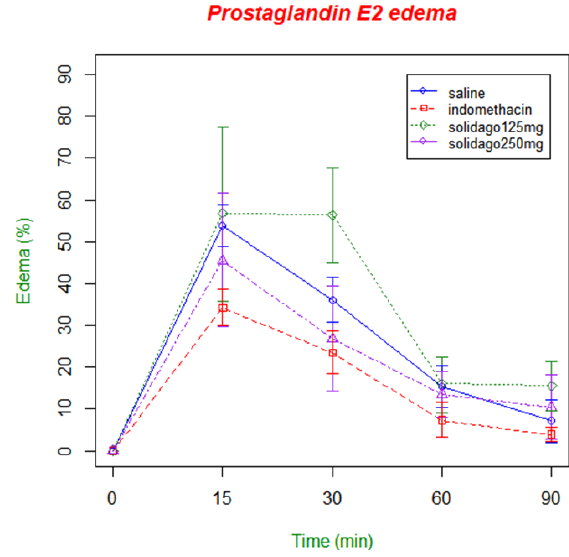
Figure 7 . Variation in paw thickness percent 15 to 90 min after PGE2 administration. Animals were pretreated with vehicle (saline solution + 1% Tween 80, 10 ml/kg), indomethacin 10 mg/kg, S. microglossa extract 125 mg/kg or S . microglossa extract 250 mg/ kg 30 min before intraplantar injection of PGE2 (20 μg/ paw). Edema was measured with a digital caliper at each time point marked. N=8 for all groups. Statistical analyses were performed between the treated groups and the group treated only with the vehicle at certain times (15 min, 30 min, 60 min, and 90 min). Analysis of variance (two-way ANOVA) followed by Tukey’s multiple comparison of the means at the 95% familywise confidence level.